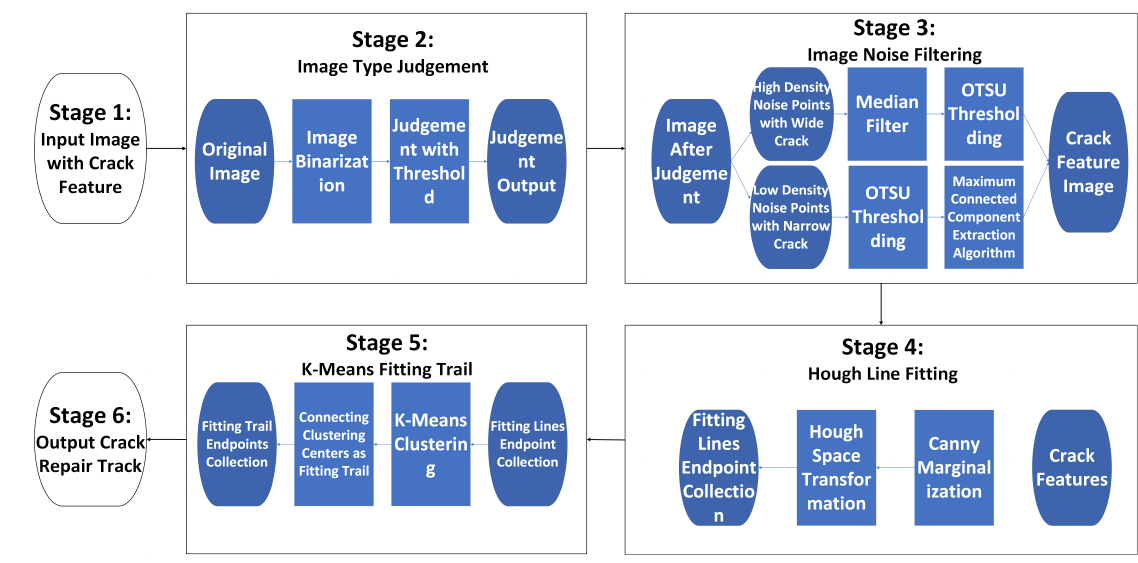
Figure 1. Algorithm Framework.